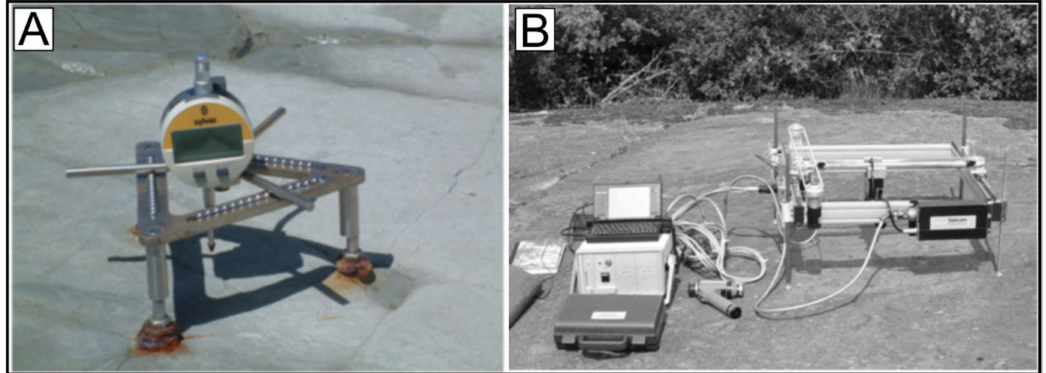
Figure 4. Current existing tools for platform downwearing. Photograph ( A ): MEM tool attached to the platform (image reprinted from Stephenson and Finlayson, 2009: p.55 [37]), photograph ( B ): laser scanning equipment (image reprinted from Swantesson, 2005: p.16